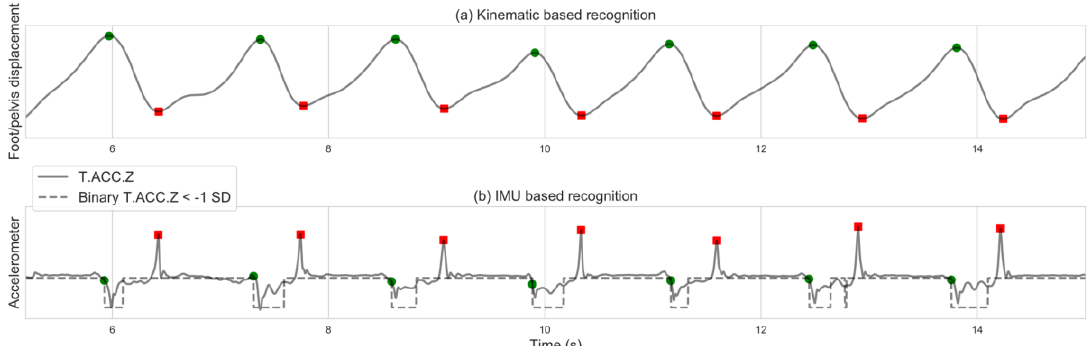
Figure 3. Backward walking gait events identification based on: ( a ) kinematic data; ( b ) IMU data. Red squares indicate initial foot contact; green circles indicate terminal foot contact.